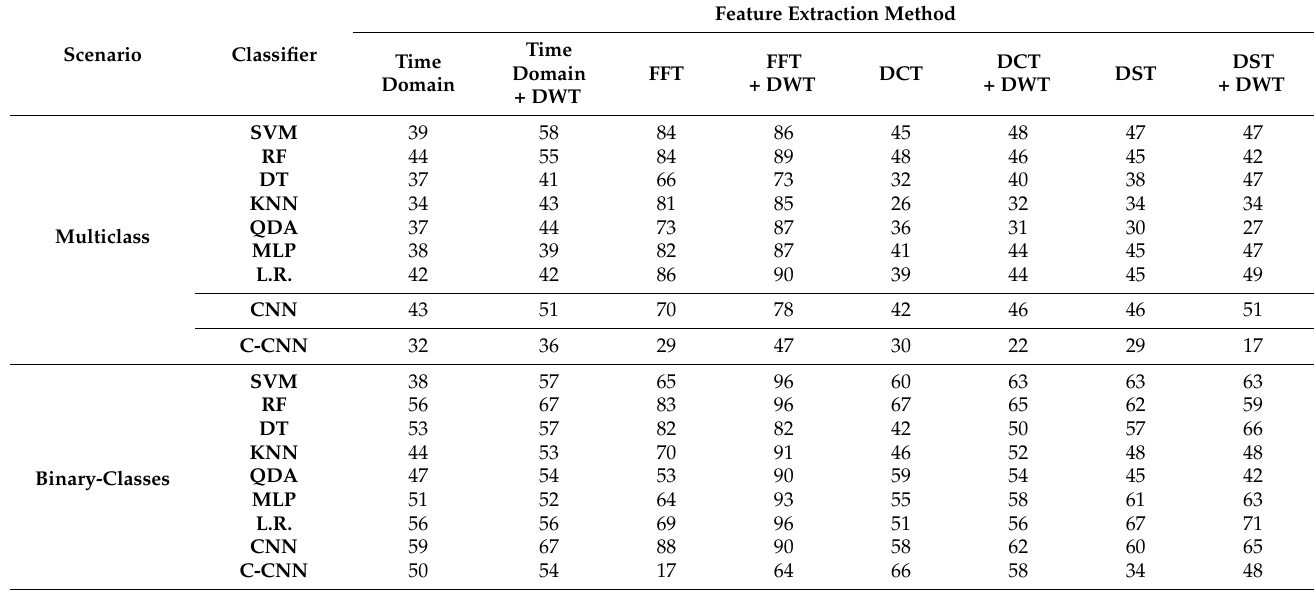
Table 5. Brief Comparison among The F1-score of The Proposed Machine Learning Models in Different Domains.